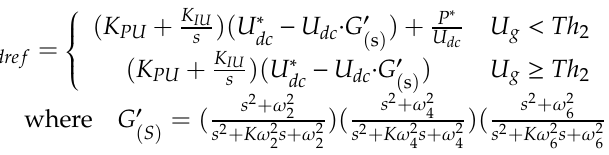
Figure 7. Detected value of fundamental signal: ( a ) Voltage sag initiation process; ( b ) Voltage sag recovery process.